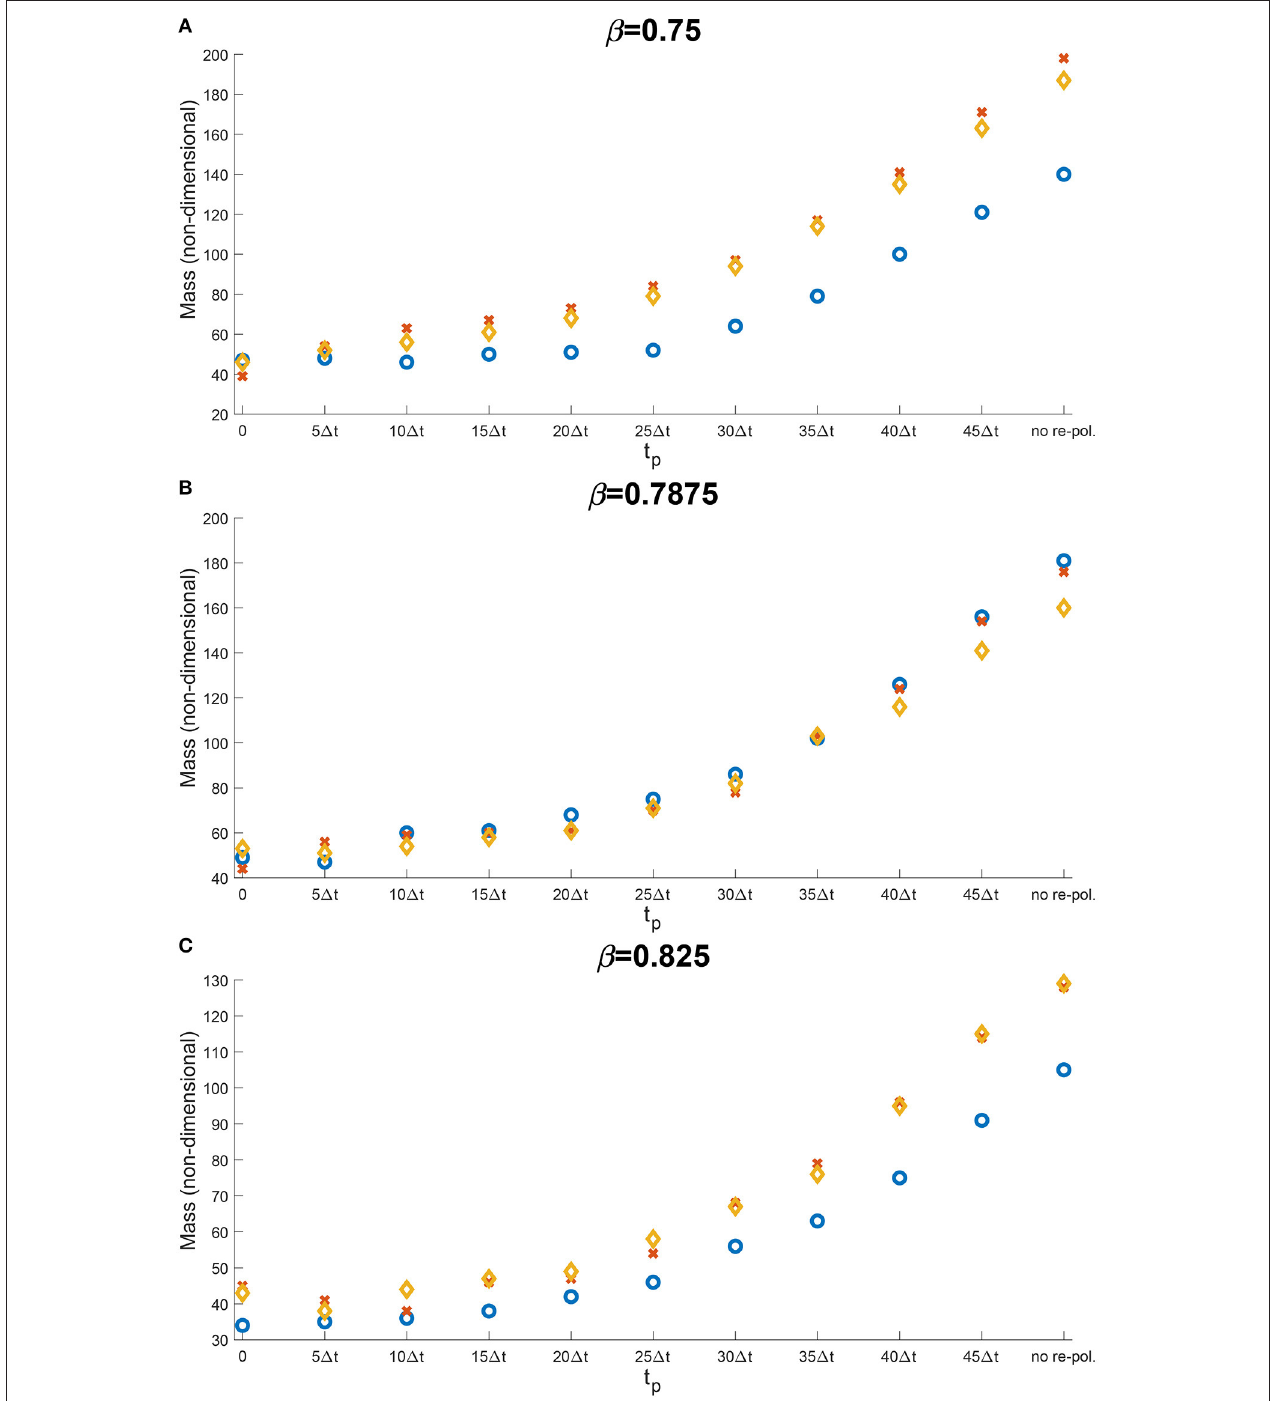
FIGURE 10 | Results of varying the re-polarisation start time t p ∈ { 0,5 1 t , ... ,45 1 t ,50 1 t } . The blue circles correspond to a high ECM degradation rates by cancer cells ( β lc = 3.0, β Fc = 1.5, α c = 0.625), the orange diamonds to medium ECM degradation rates ( β lc = 2.0, β Fc = 1.0, α c = 0.42) and the red crosses to low ECM degradation rates ( β lc = 1.0, β Fc = 0.5, α c = 0.21). The environment controller β is set to (A) β = 0.75, (B) β = 0.7875, and (C) β =